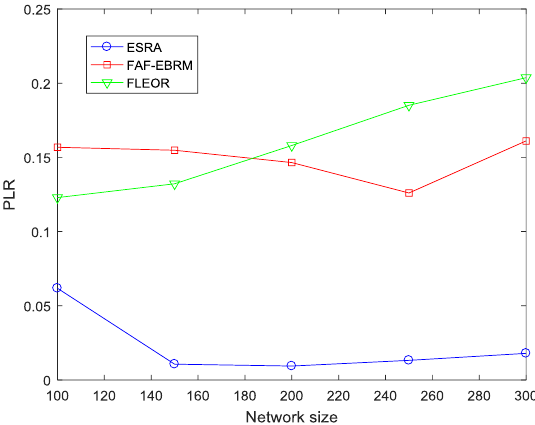
Figure 9. The PLR comparisons with varying network size.